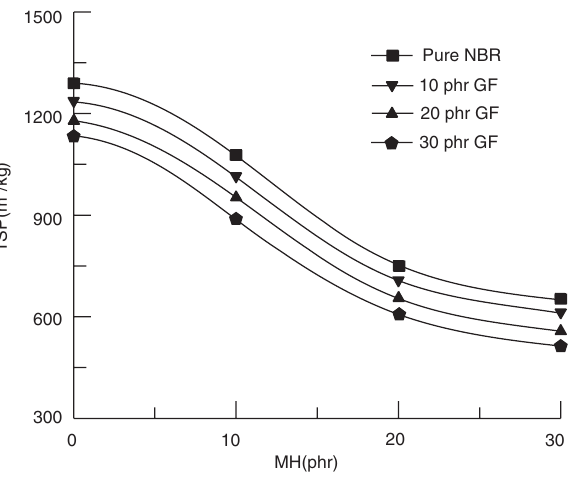
Figure 8 TSP curves for nano MH/GF/NBR composite material with different MH/GF fraction